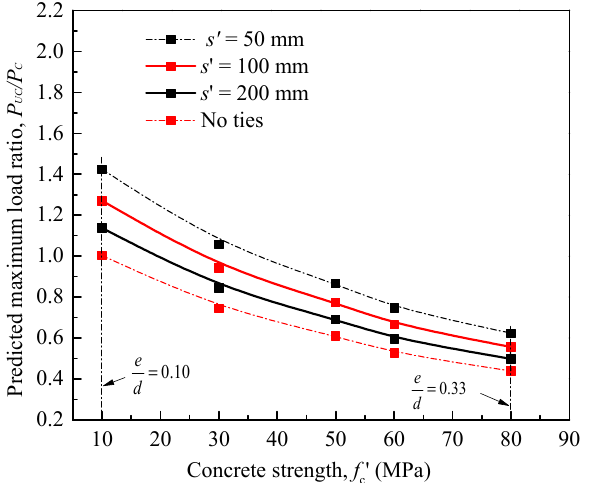
Figure 9. Relationship between the relative load ratio and the concrete compression strength for specimens with different steel hoops and small eccentricity